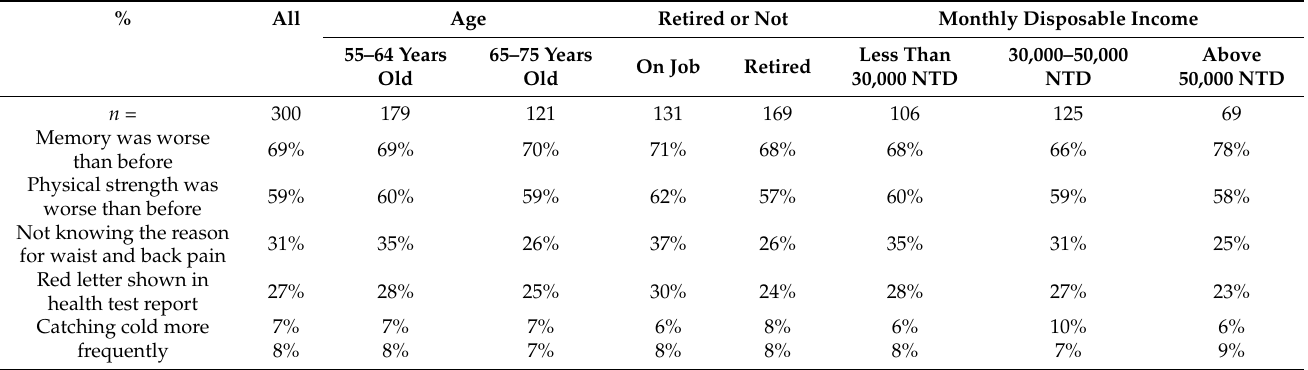
Table 2. Self-health situation for those aged 55–75, as compared to their self-health situation three years ago.